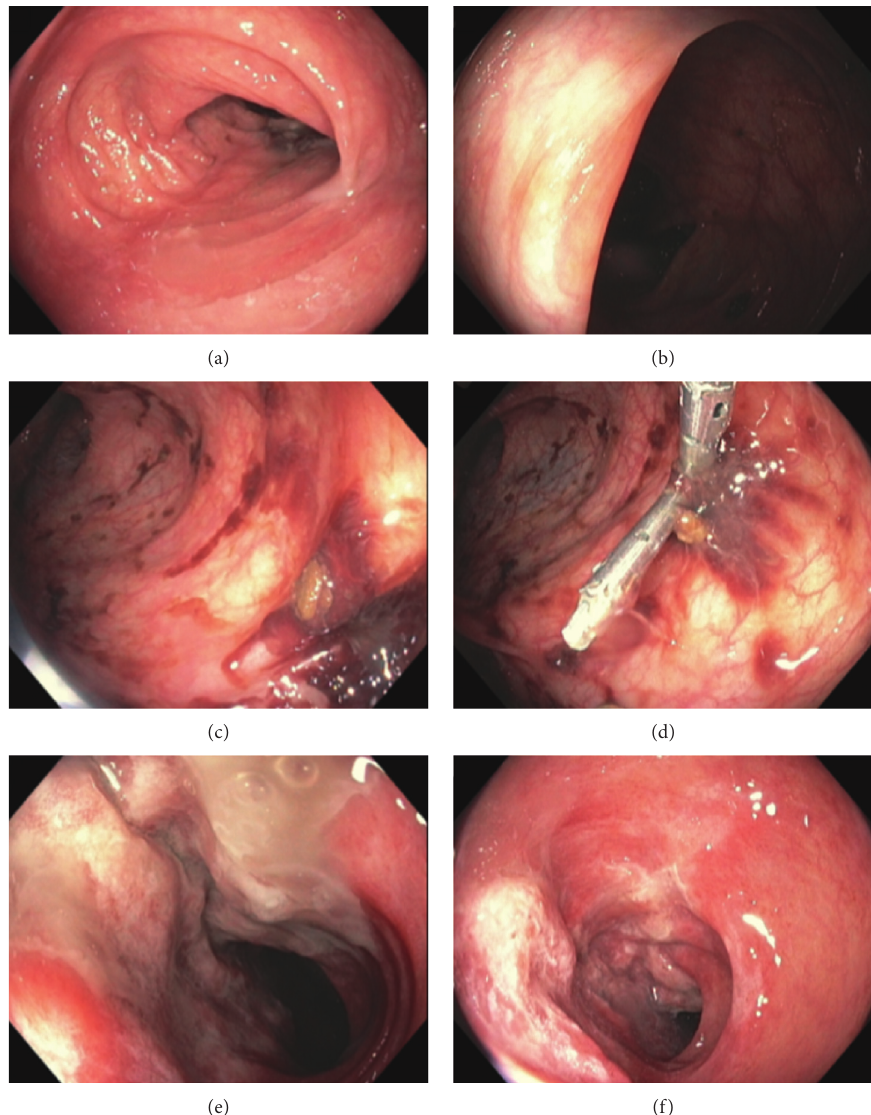
Figure 4: Endoscopic images demonstrating the noncircumferential segment of erythema and friability without submucosal edema or ulceration (1–6). Site of increased blood where a clip was placed